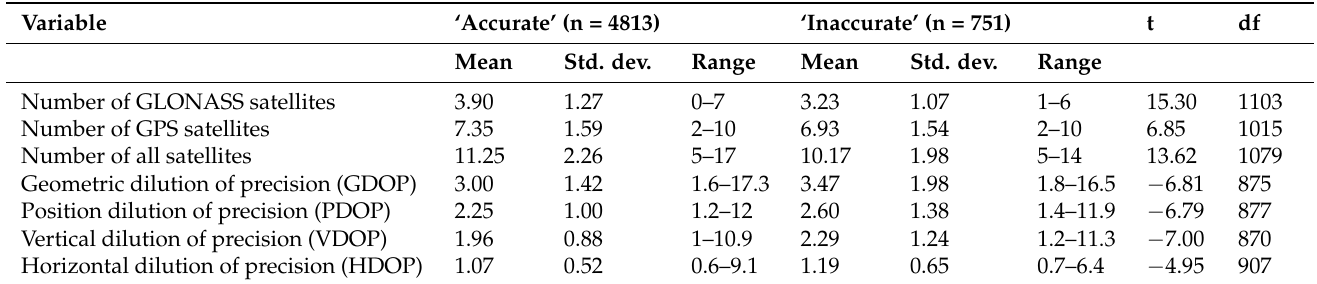
Table 2. Assessment of the geometric quality of GNSS signals for determining position solutions with a Trimble R12 GNSS receiver showing significant difference from pairwise test p < 0.001.